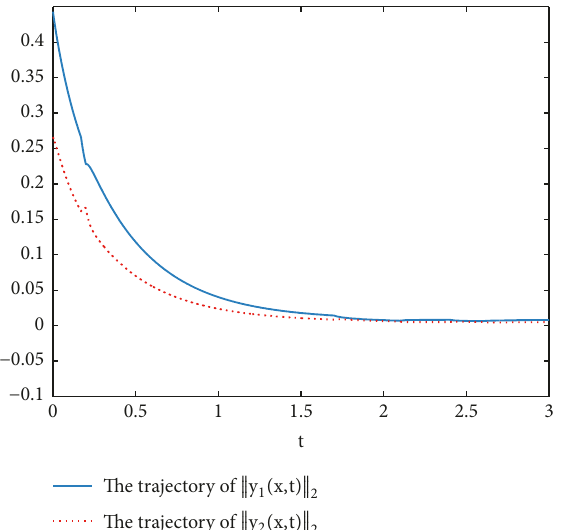
Figure 5: The closed-loop trajectories of ‖𝑦 1 (𝑥,𝑡)‖ 2 and ‖𝑦 2 (𝑥,𝑡)‖ 2 .